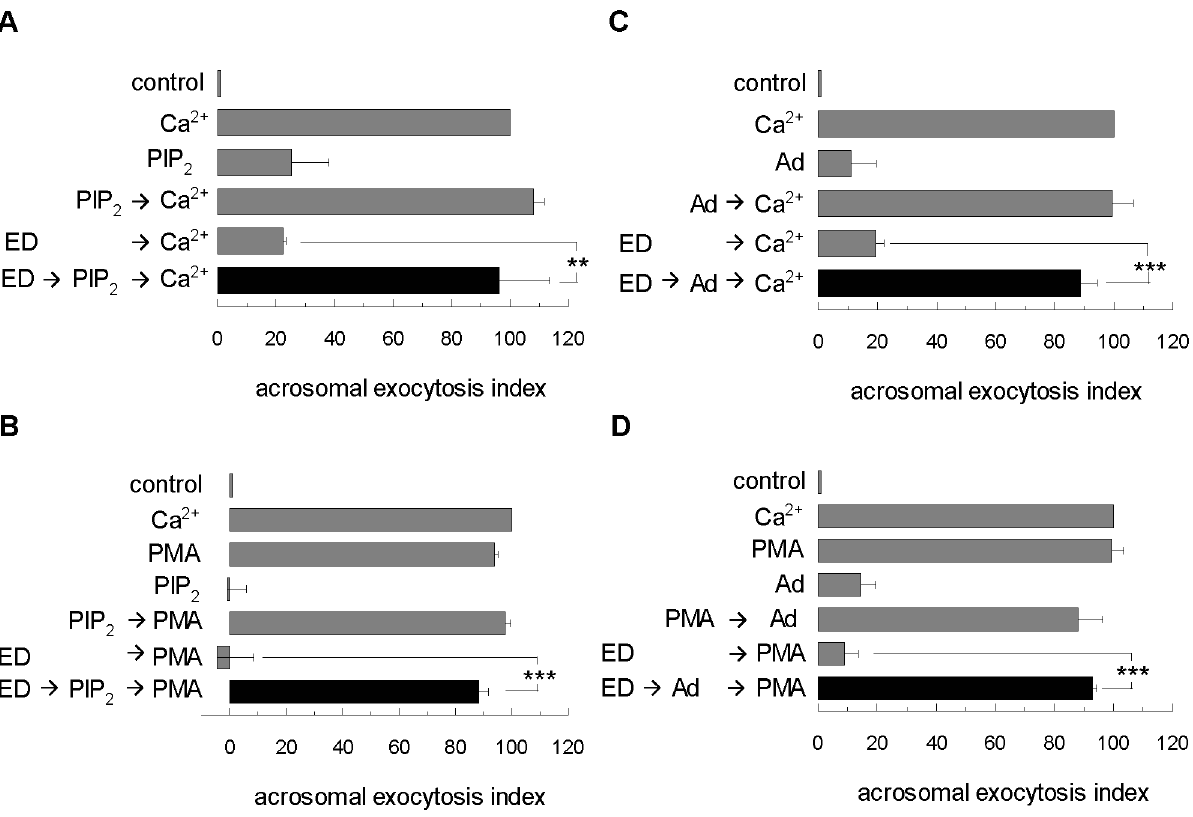
Figure 4. PIP 2 and adenophostin rescue inhibition of MARCKS effector domain in acrosomal exocytosis. Permeabilized sperm were treated for 15 minutes at 37 u C with 1 m M MARCKS effector domain (ED); then, 50 m M PIP 2 was added for another 15 min and acrosomal exocytosis was initiated by adding 10 m M free Ca 2 + ( A ) or 200 nM PMA ( B ). The incubation continued for an additional 15 minutes (black bars). Control experimental conditions (gray bars) include background acrosomal exocytosis in the absence of any stimulation (control), acrosomal exocytosis stimulated by 10 m M free Ca 2 + (Ca 2 + ) and by 200 nM PMA (PMA), the absence of effect of PIP 2 with or without acrosomal exocytosis stimulation. Permeabilized sperm were treated for 15 minutes at 37 u C with 1 m M MARCKS effector domain (ED); then, 5 m M adenophostin was added (Ad), and acrosomal exocytosis was initiated by adding 10 m M free Ca 2 + ( C ) or 200 nM PMA ( D ). The incubation continued for an additional 15 minutes (black bars). Control experimental conditions (gray bars) include background acrosomal exocytosis in the absence of any stimulation (control), acrosomal exocytosis stimulated by 10 m M free Ca 2 + (Ca 2 + ) and by 200 nM PMA (PMA), the absence of effect of adenophostin with or without acrosomal exocytosis stimulation, and the inhibitory effect of ED in acrosomal exocytosis. The percentage of reacted sperm was normalized as described in Materials and Methods. The data represent the means 6 SEM of at least three independent experiments. The asterisks indicate significant differences from similar conditions without PIP 2 or adenophostin (**, p , 0.01; ***, p ,